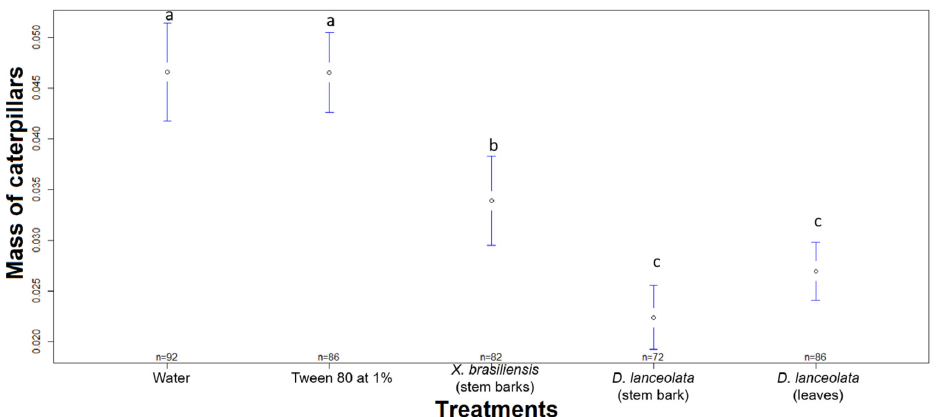
Figure 5. Mass of Spodoptera frugiperda caterpillars offered an artificial diet containing essential oils of Duguetia lanceolata (leaves and stem barks) and Xylopia brasiliensis (stem bark). The same letters do not differ statistically by the test of Kruskal-Wallis.